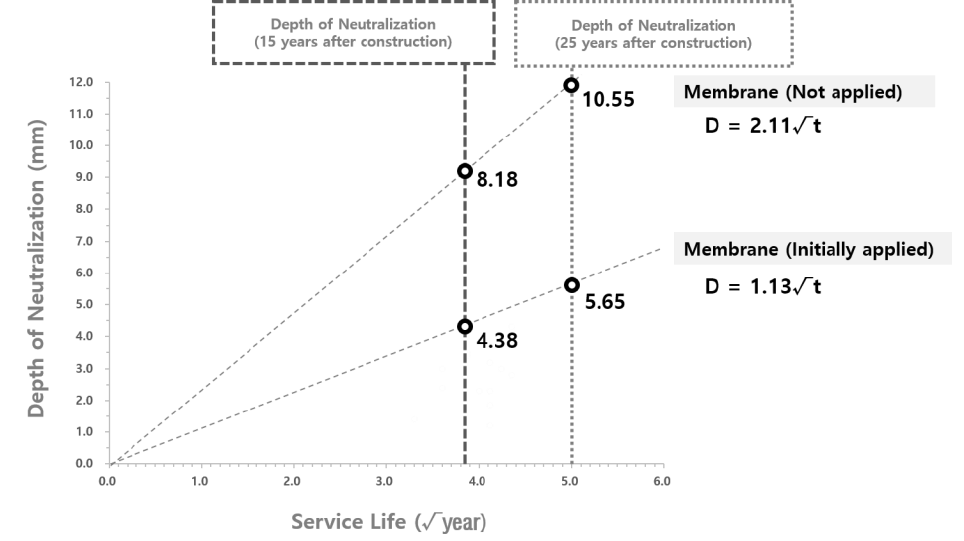
Figure 11. Comparison of carbonation rate coefficients of water reservoirs with or without application of the waterproofing/anticorrosive method (upper limits).